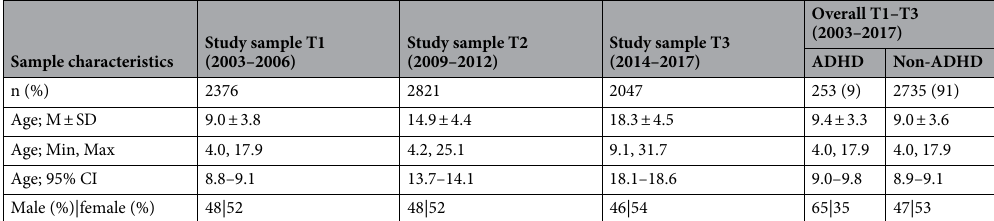
Table 1. Characteristics of the study samples (T1, T2, and T3). Data are either the mean values (M) ± standard deviation (SD), minimum (Min), maximum (Max), and 95% CI = confidence interval or percent (%), age